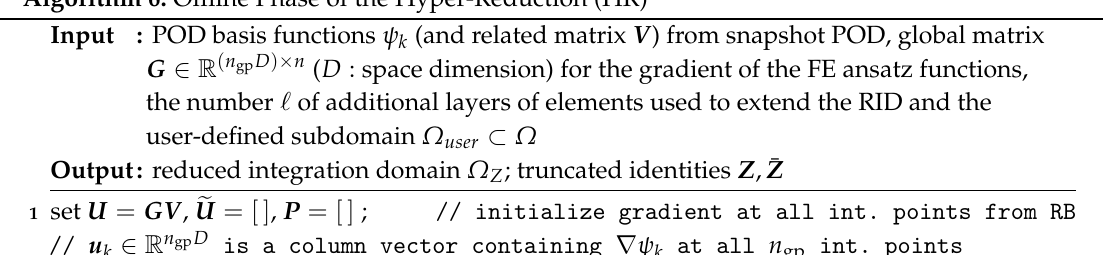
Algorithm 6: Offline Phase of the Hyper-Reduction (HR)